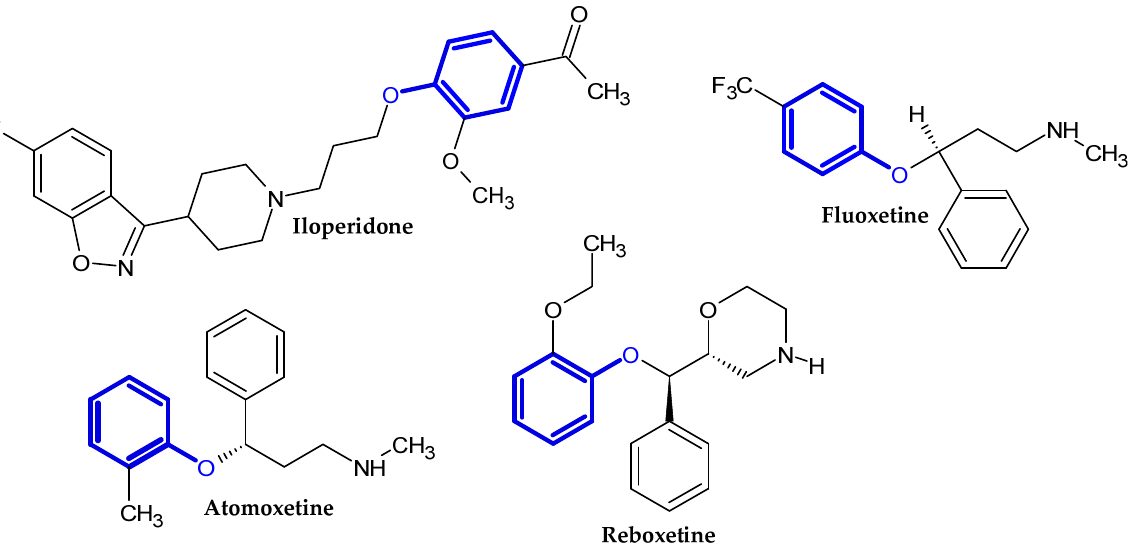
Figure 2. Drugs currently used in the treatment of neurological disorders.